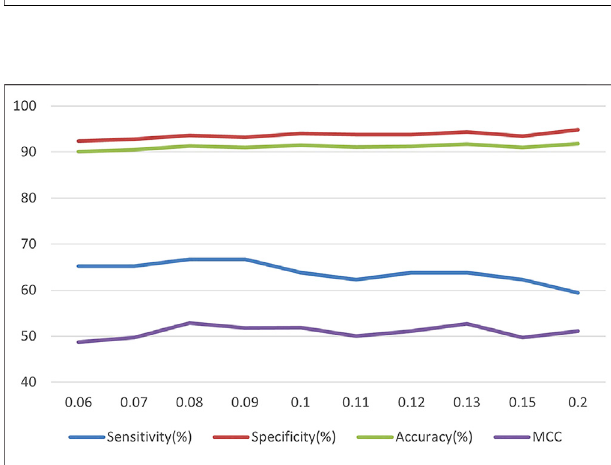
FIGURE 3 | The relationship between the number of maxdepth and model performance.